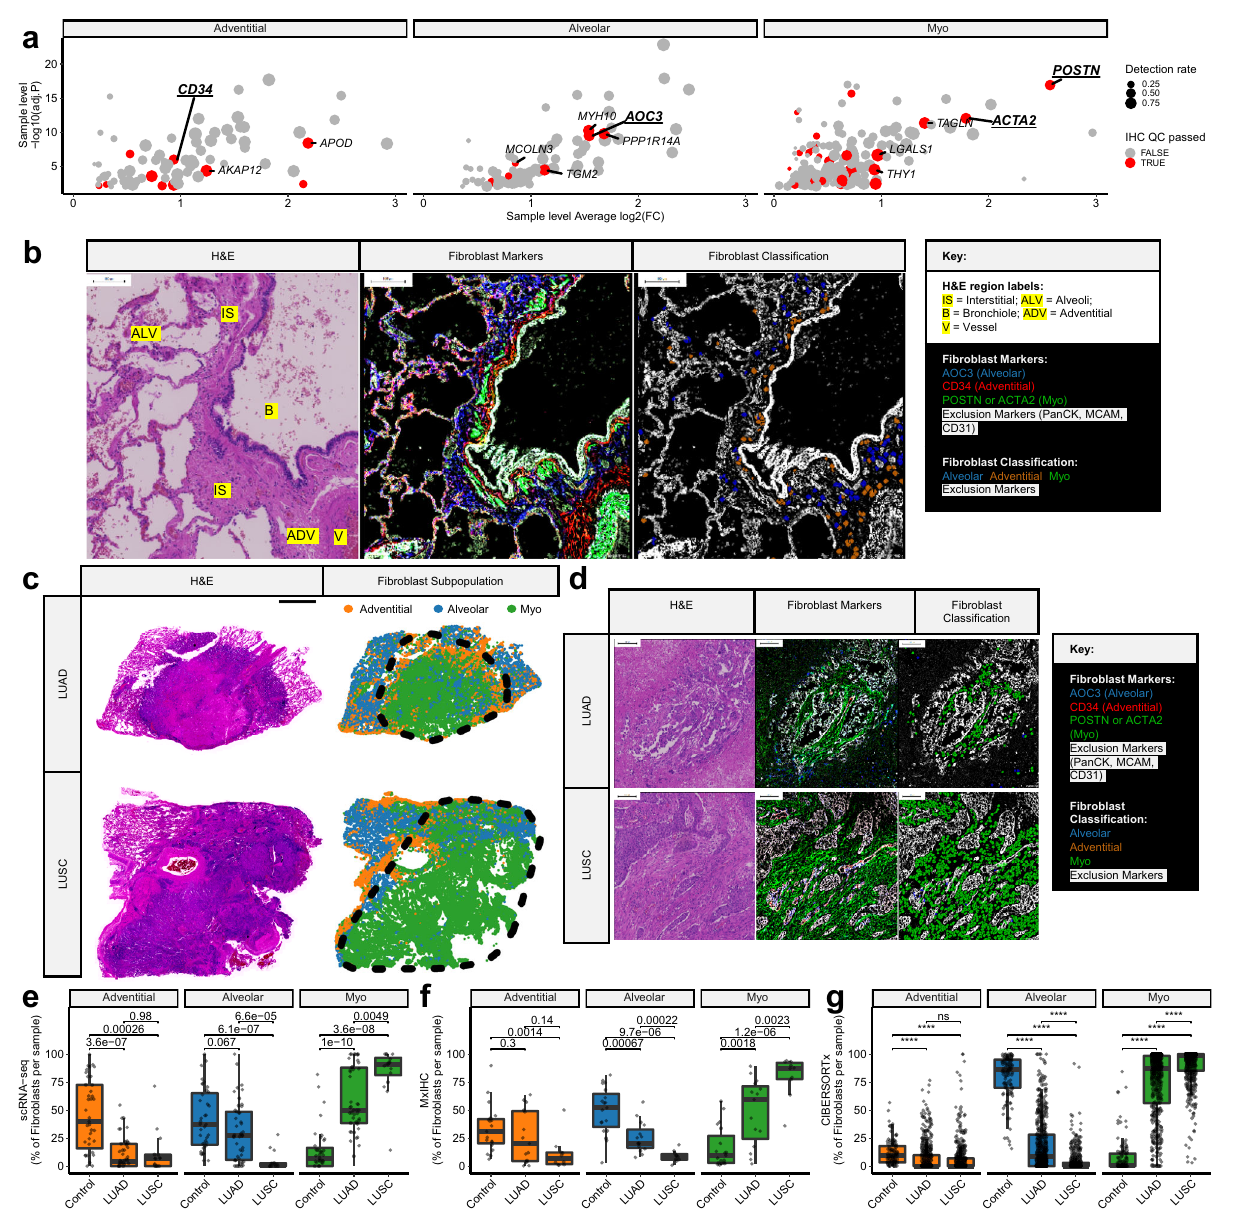
Fig. 3 | Multiplexed IHC (mxIHC) and digital cytometry show that fi broblast subpopulations occupy spatially discrete niches and varied NSCLC tissue subtype enrichment. a Scatter plot showing differential expression statistics (Bonferroni adj. P and log2 fold change) for putative subpopulation markers, highlightingthosecompatibleforuseinmxIHCanalysis.Fulldetailsareprovidedin Supplementary Data 2. b Representative micrographs from H&E staining and multiplexed IHC (mxIHC) performed on serial sections ( n =19 samples analysed). The micrographs (from left to right) represent H&E staining (notable regions are highlighted as described in the key), a pseudocoloured image depicting different markersidenti fi edbymxIHC(colouredasindicatedinthekey)andtheresultsfrom histo-cytometry-basedcellclassi fi cation(withsimulatedcellscolouredasindicated in the key). The region presented represents histologically normal lung tissue, including adventitial, alveolar, peri-bronchial and interstitial regions. Scale bars represent 100 µ m. For further images showing region of interest selection and individual marker staining pro fi les please see Supplementary Data 6. c Repre- sentative examples from whole slide mxIHC analysis of NSCLC tissue sections ( n =15 [LUAD], 10 [LUSC] samples analysed). Panels showing serial section H&E staining and a point pattern plot showing the spatial distribution of different fi broblastpopulations(measured byhisto-cytometryanalysisof mxIHC).Thescale